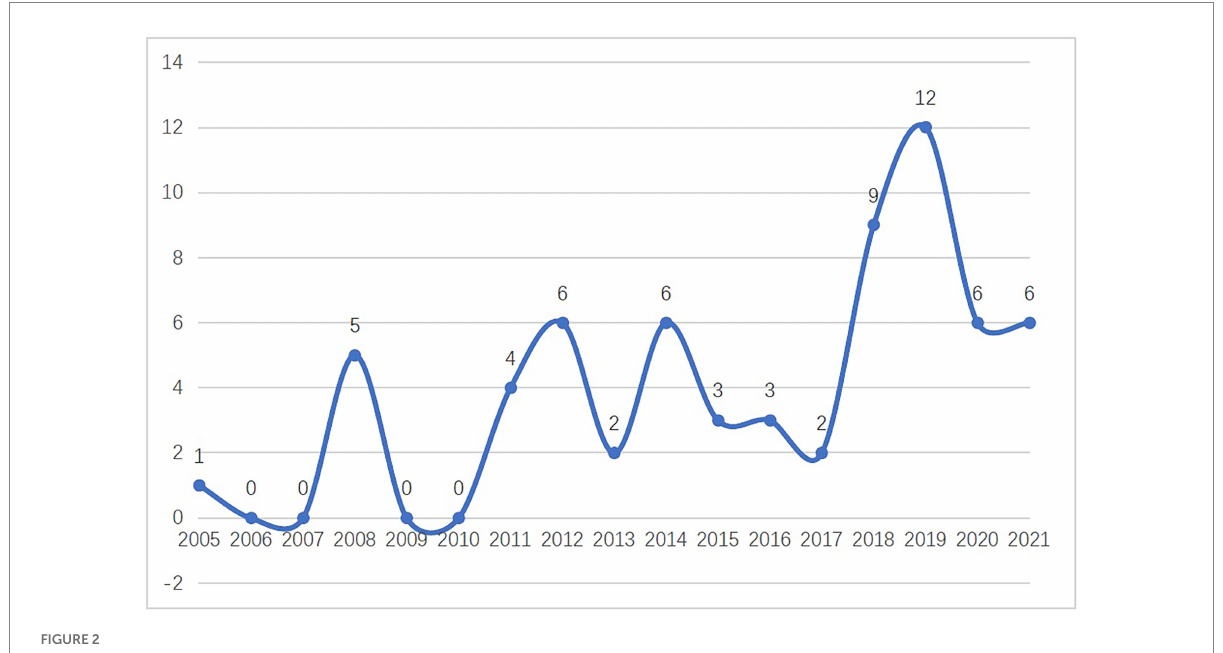
FIGURE 2 Annual publications from 2005 to 2021 in the research